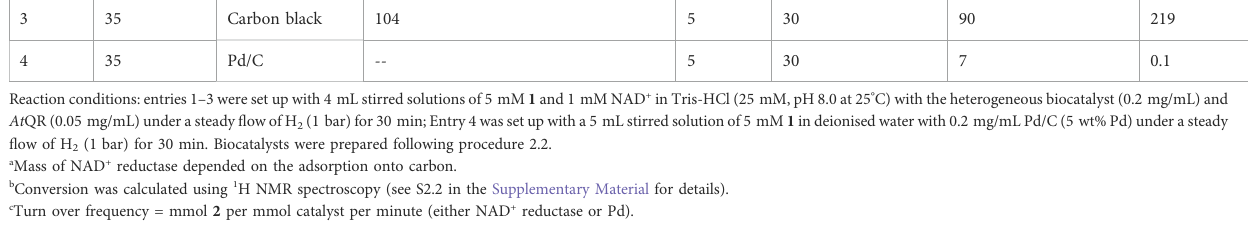
(Figure 3). Here, we sought to achieve key reaction parameters required for translation into continuous fl ow slurry process, including short reaction times and low (0.2 – 0.6 mg/mL) catalyst loading.